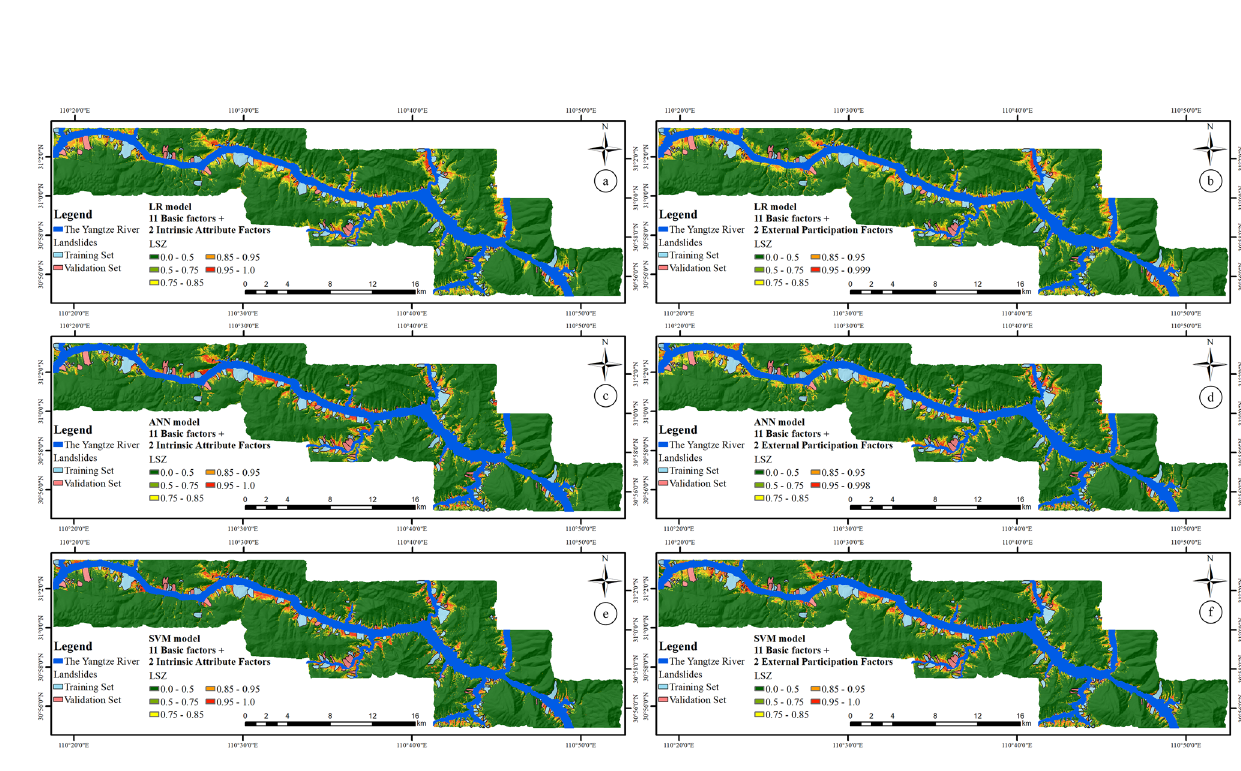
Figure 16. LSZ based on the 11 basic factors and ( a ) intrinsic attribute factors by LR model, ( b ) external participation factors by LR model, ( c ) intrinsic attribute factors by ANN model, ( d ) external participation factors by ANN model, ( e ) intrinsic attribute factors by SVM model, and ( f ) external participation factors by SVM